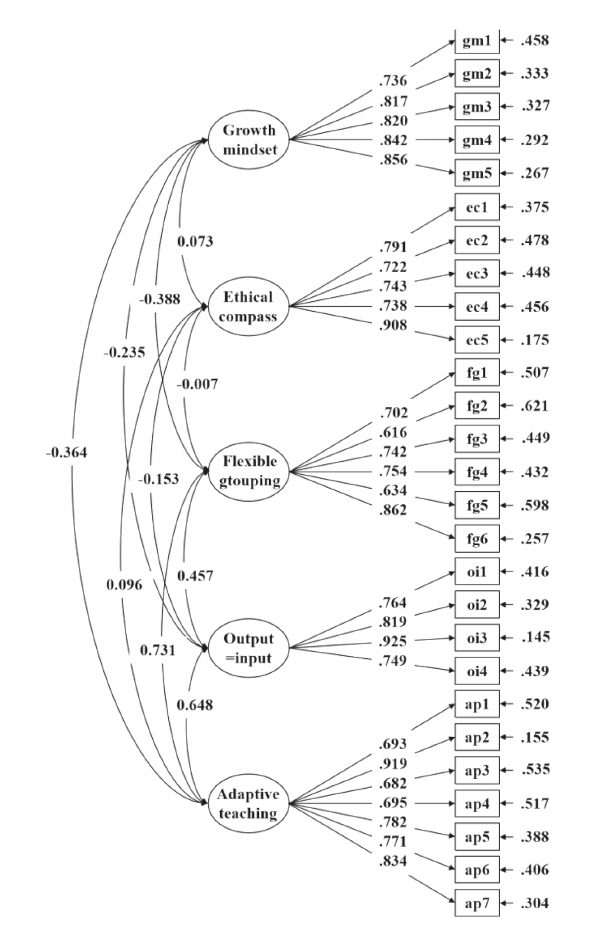
FIGURE 2 The measurement model of Chinese version DI-Quest instrument; N = 844. Coefficients presented are standardized